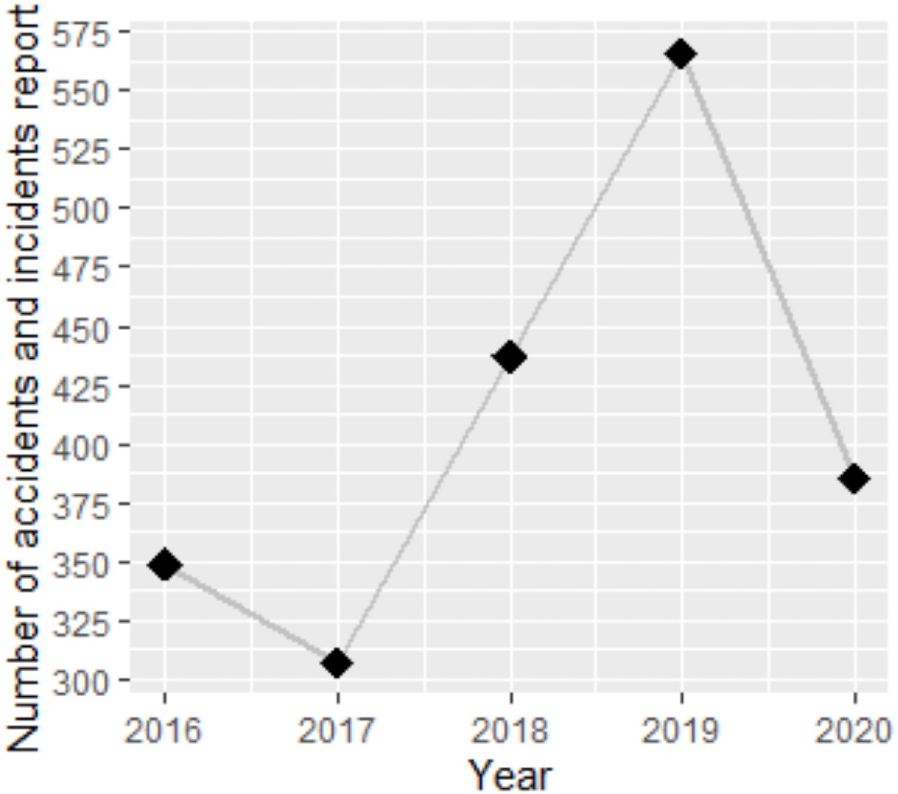
Fig 2. Count of self-reported horse related injuries submitted to the BHS Incident reporting website between March and August across a 5-year timeframe. The number of self-reported incidents and injuries relating to horses between the months of March and August across a five-year time period between 2016 and 2020. The figures shown are those submitted to the BHS incident reporting site